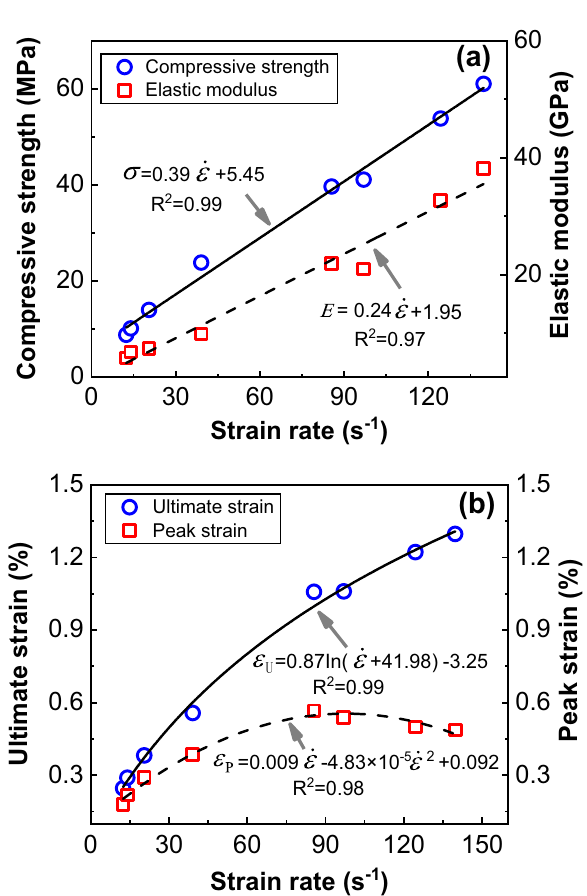
Figure 13. Fitting diagram of dynamic mechanical parameters changing with strain rate. ( a ) compressive strength and elastic modulus, ( b ) ultimate strain and peak